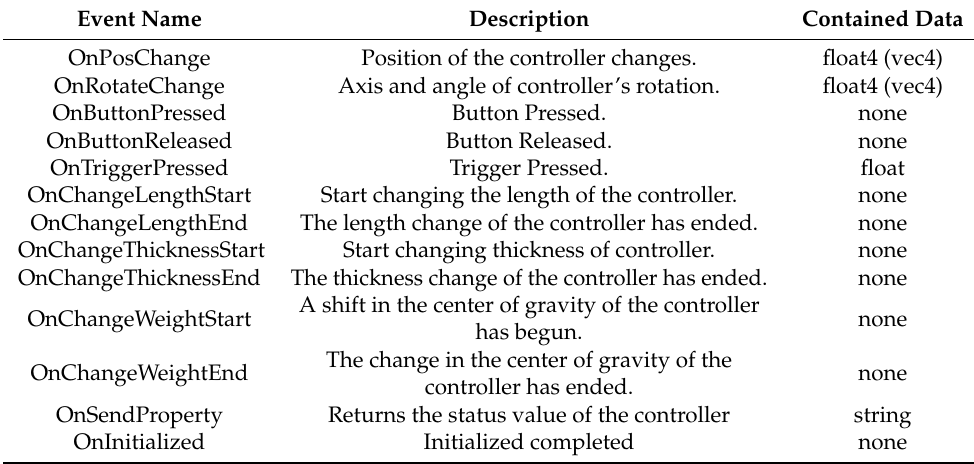
Figure 6. VR content for experiments. Table 1. Client-side event list of